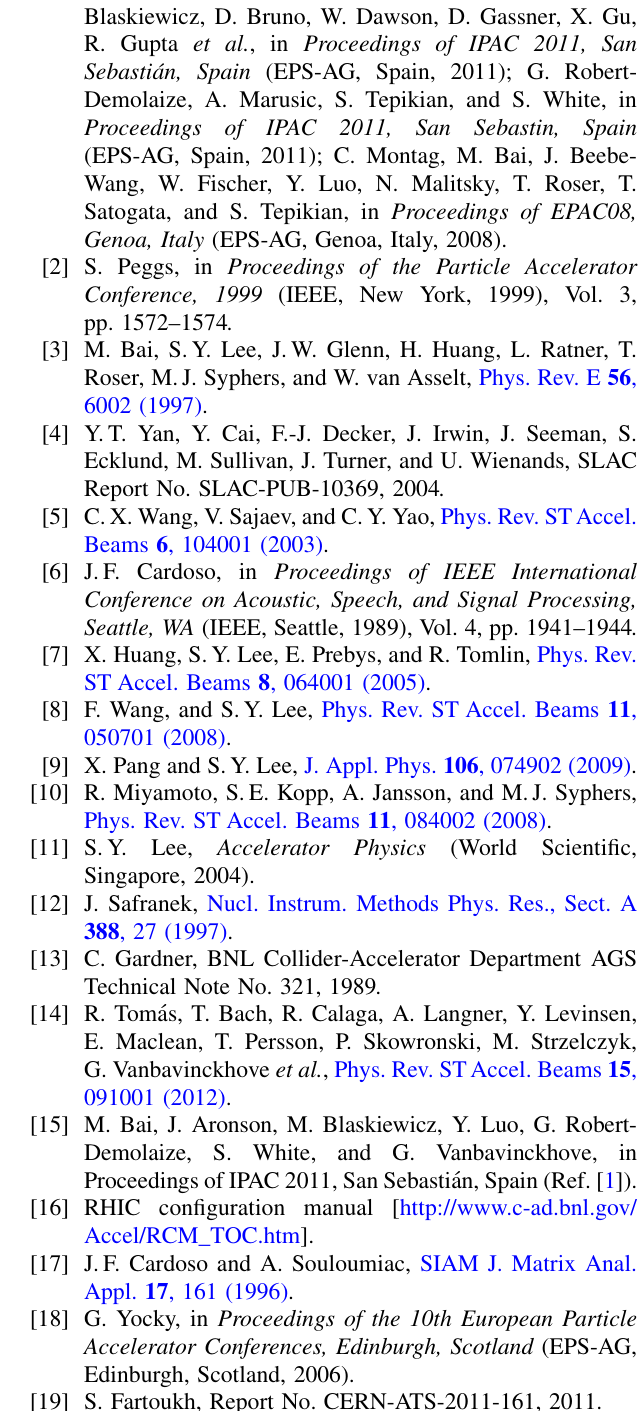
FIG. 15. Histogram of BPM noise levels estimated from a total of 37 turn by turn BPM data. In each set of data there are 68 arc BPMs and 88 other BPMs on